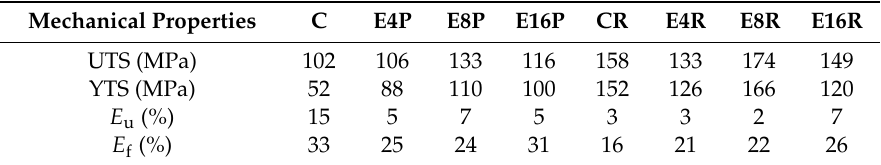
Table 2. Tensile test properties of as-cast, ECAP and ECAP-rolled Mg-9Li alloy.